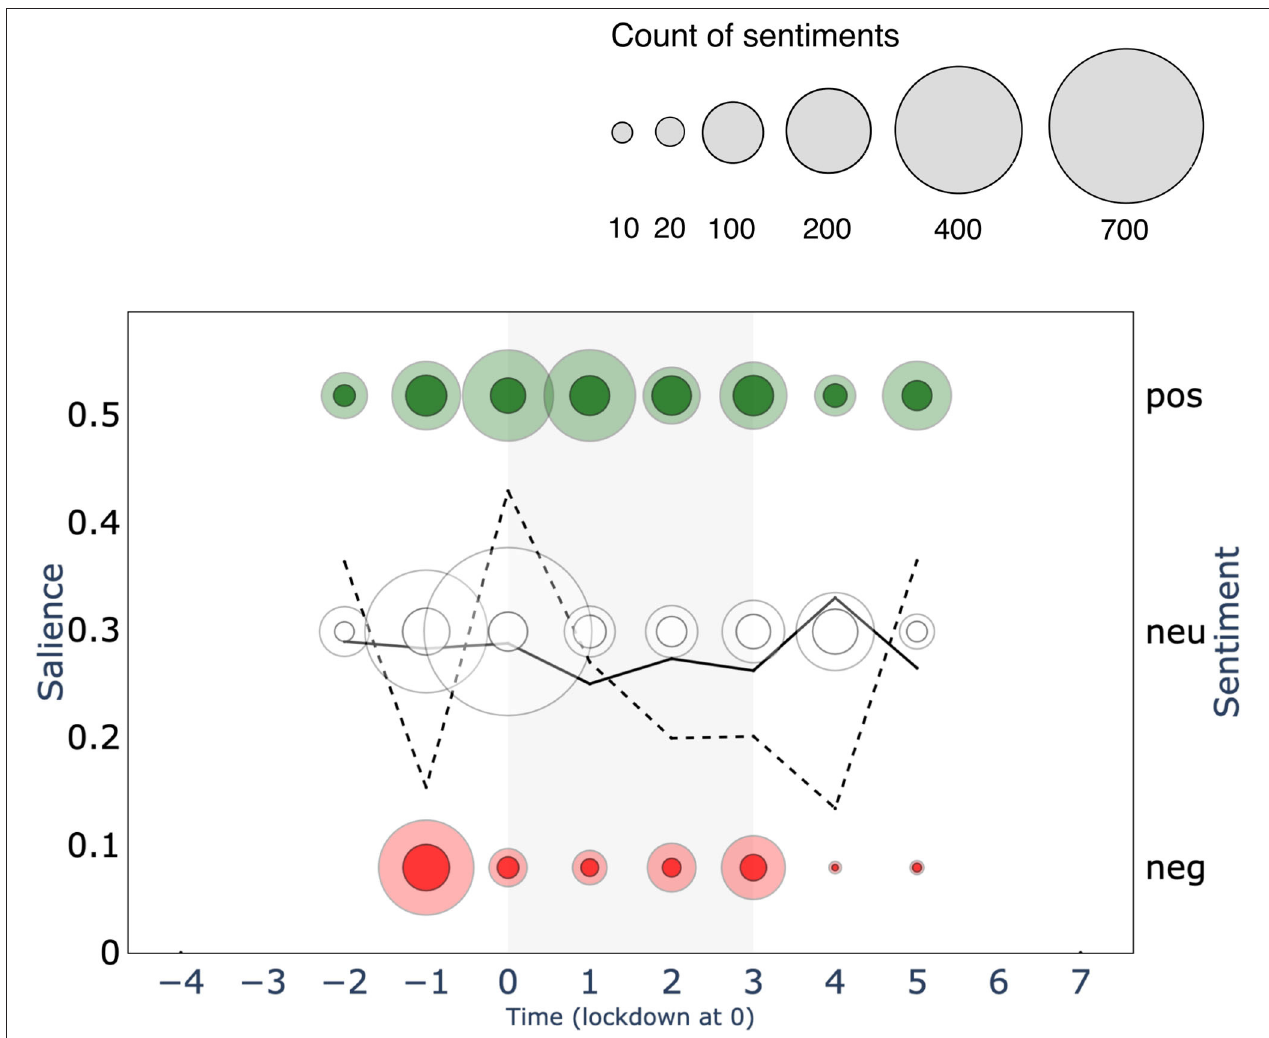
FIGURE 9 | Salience and sentiment of “ Behavioural Science ” over the 8 two-week time-period surrounding the first British national lockdown of 2020 (gray area) in Twitter data. Salience is calculated as the proportion of tweets in that 2-week period that mention the keyword. Bold line represents salience in original tweets only; Dotted line represents salience accounting for retweets also. Sentiments are represented in counts of positive ( + 1 or + 2), neutral (0), and negative ( − 2 or − 1) bubbles over time, in green, white and red respectively. The area of the bubbles is proportional to the count of sentiments. Full-color bubbles represent sentiments in original tweets only; shaded-color bubbles represent sentiments accounting for